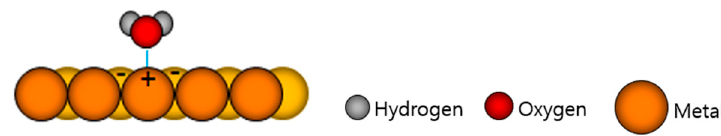
Figure 9. Example of a moisture particle adsorbed on metal by image force [97].